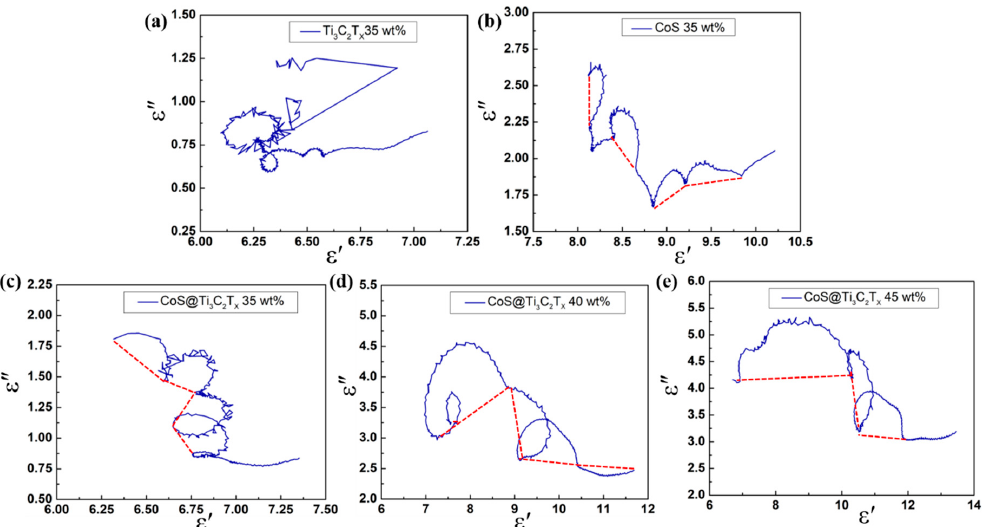
Figure 9. Typical Cole–Cole plots of Ti 3 C 2 T x (35 wt %) ( a ), CoS (35 wt %) ( b ), CoS@Ti 3 C 2 T x (35 wt %)